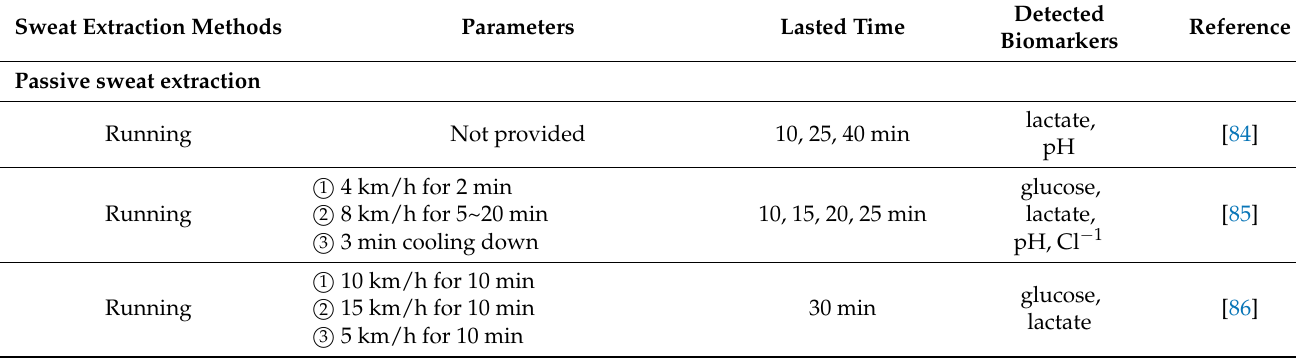
Table 2. Passive and active sweat extraction